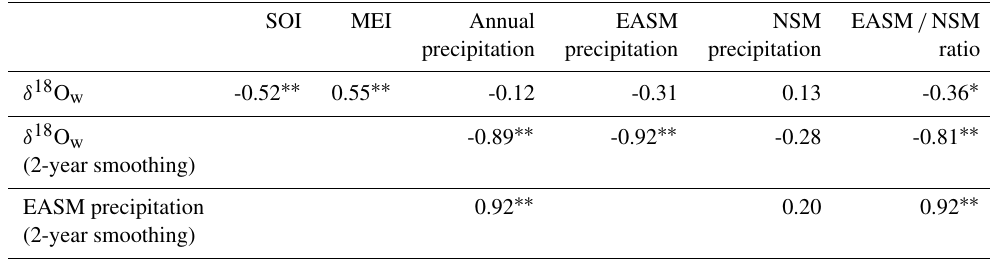
Table 2. Correlation coefficients between the time series of precipitation δ 18 O w ; MEI; the EASM / NSM ratio; and the annual, EASM, and NSM precipitation amounts in the SPR region for 1979–2009. The temporal coverage of the annual precipitation and the precipitation δ 18 O w is from May to next April, the EASM precipitation is from May to September, and the NSM precipitation is from October to next April. The temporal coverage of the MEI and the SOI is from October to April. SOI